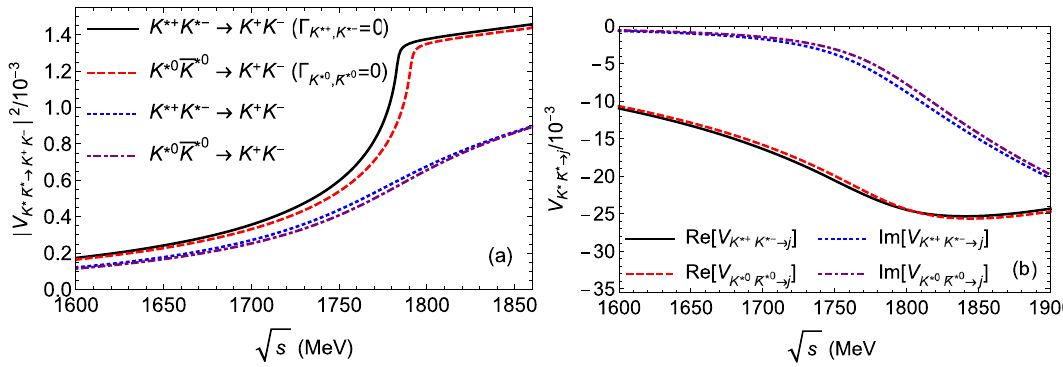
, with the final state j = K + K − . b Real and imaginary parts of K ∗ 0 ¯ K ∗ 0 , j